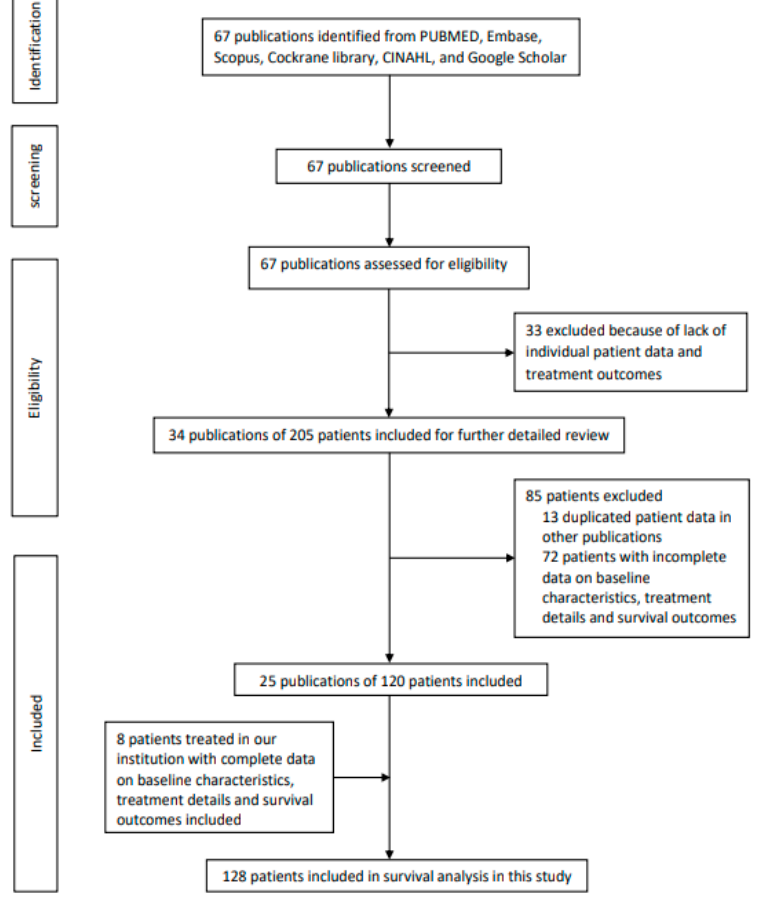
Figure 1. PRISMA flow chart showing the identification and selection of included publications and inclusion of patients treated in our institution for analysis.